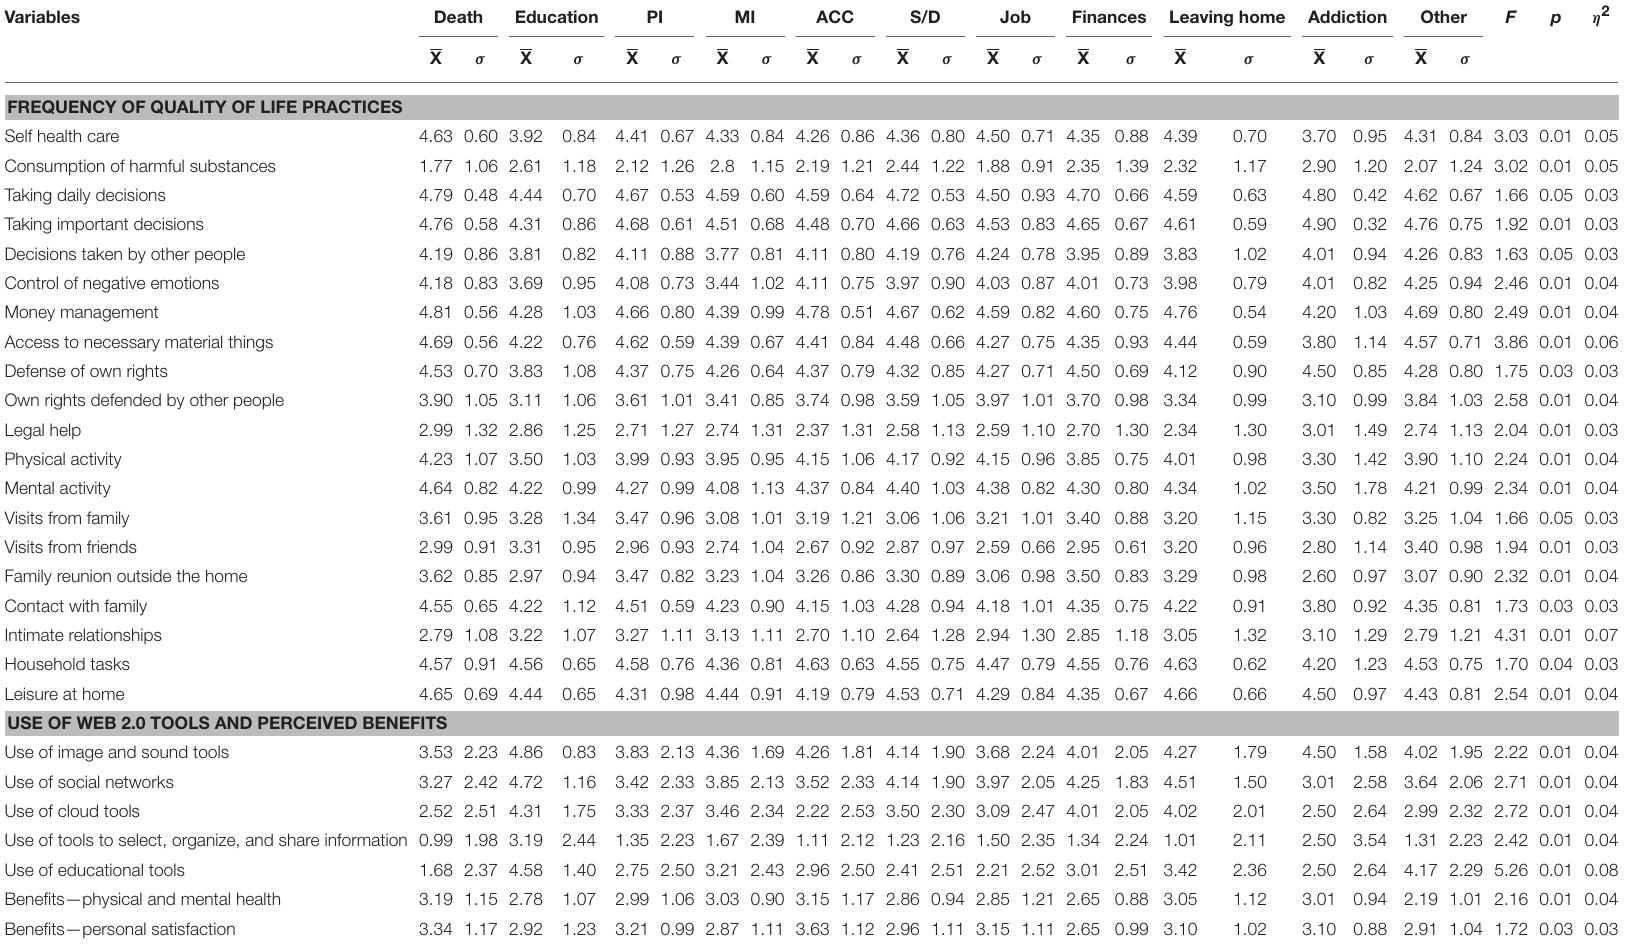
TABLE 5 | Differential patterns in quality of life practices, use of web 2.0 tools, and perceived benefits according to stressful life experiences.